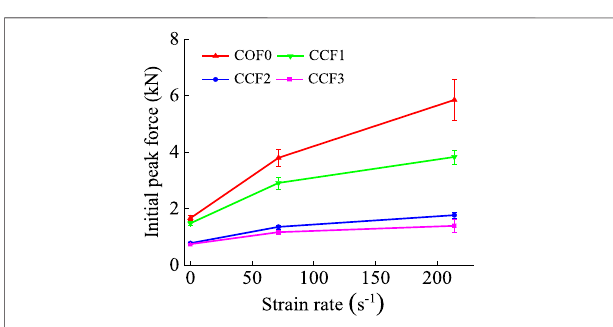
FIGURE 6 | The initial peak force-strain rate curve for the four types of foams: COF0,CCF1, CCF2, and CCF3.